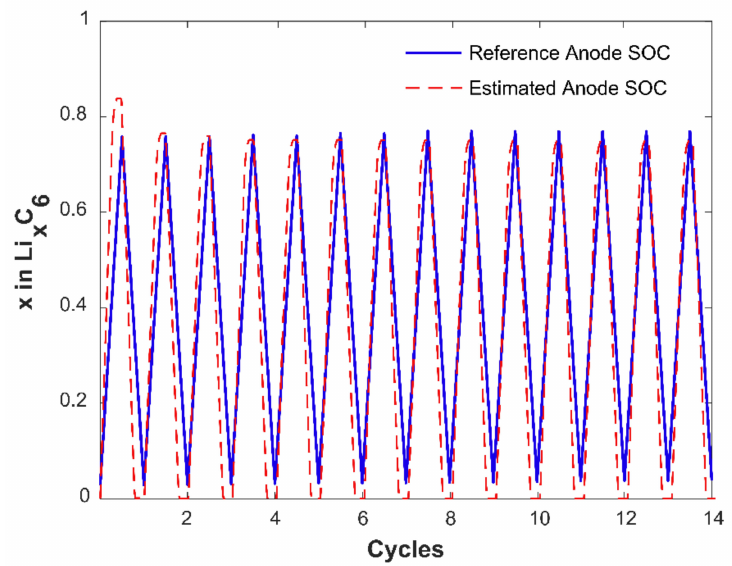
Figure 12. Comparison between estimated anode SOC (red dashed) and the reference anode SOC from [1] (blue) for standard CCCV charging profile for a single three-electrode cell.